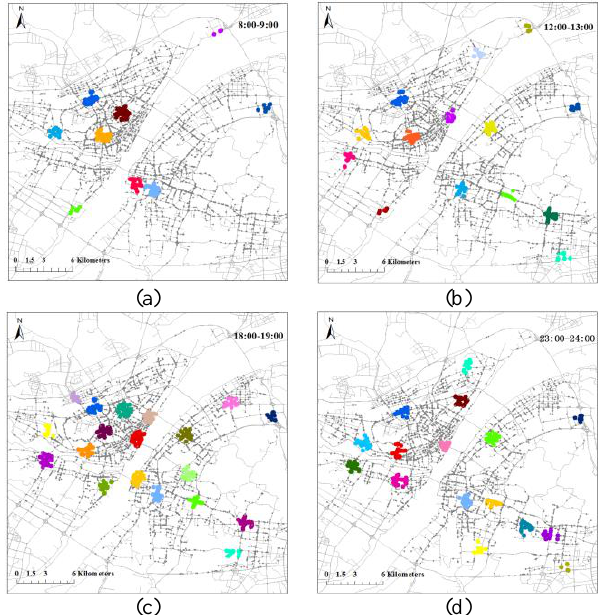
Figure 6. Hotspots on weekend (May 10 th , 2014). Comparing and analyzing the hotspot distribution maps on holiday, weekday and weekend, we find that the distribution patterns of hotspots during selected four hours are similar. For instance, some regions are constant hotspots and seldom vary with time. Represented as blue areas in Figure.4-6, the constant hotspots mainly locate on Hankou Railway Station (corresponding to the blue area in Figure. 4-6), Wuchang Railway Station (the light blue area), Wuhan Railway